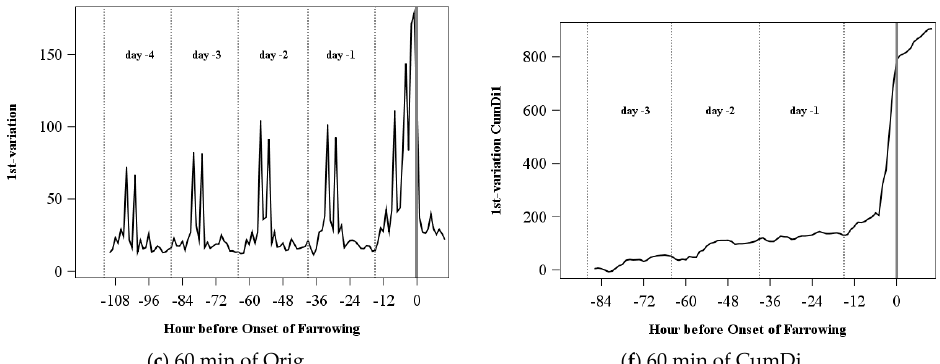
Figure 4. Time intervals 10, 30, and 60 min exemplary for the original values (Orig: a , b , c ) and the acceleration index CumDi ( d , e , f ) for the distribution parameter 1st variation with a range of the moving average of 1 for one sow.